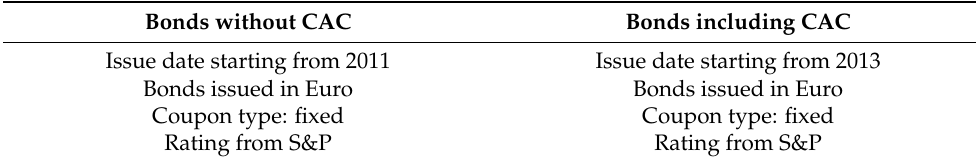
Table 1. Structuring of sovereign bonds (Source: